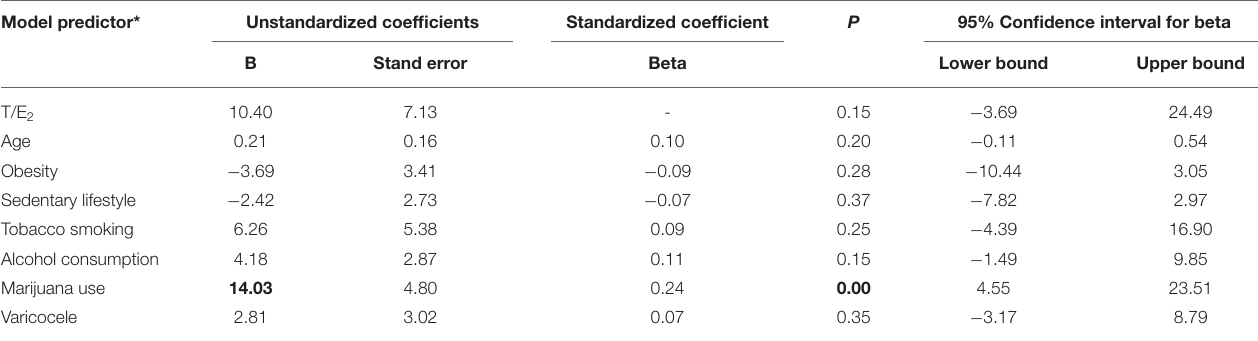
TABLE 6 | Coefficients of the multiple linear regression analysis model for dependent variable T/E 2 . Model predictor* Unstandardized coefficients Standardized coefficient